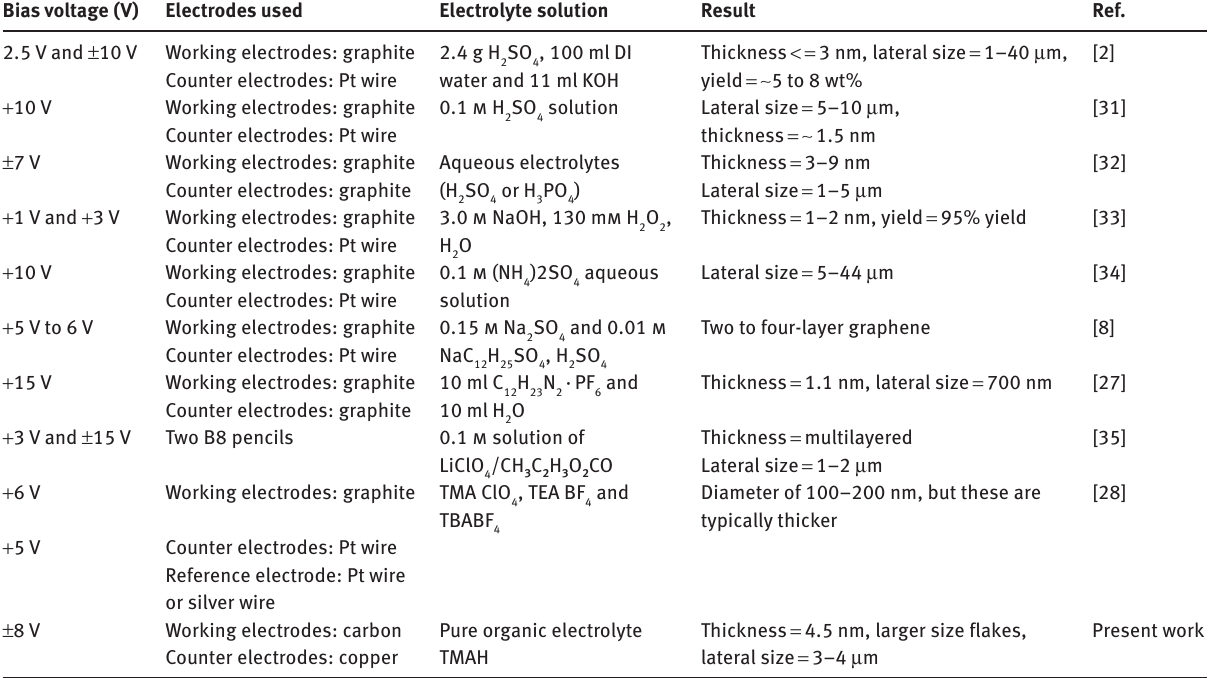
Table 1: Comparison of different electrochemical exfoliation technique for synthesis of graphene with the present work. Bias voltage